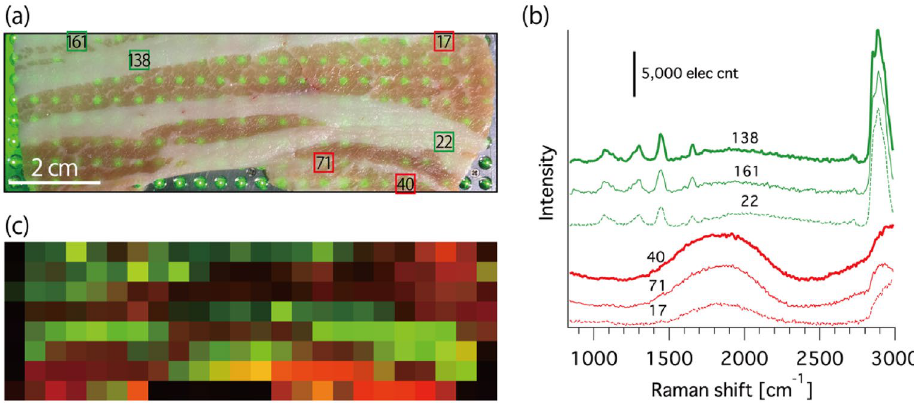
Figure 4. Chemical mapping of a large-scale sample measured by the developed Raman plate reader. ( a ) Photograph of a pork slice under illumination through multiple objective lenses. ( b ) Representative spectra obtained from the sample for the measurement time of 85 s. ( c ) Reconstructed chemical map of the sample. Green: fat (Raman intensity at 2890 cm −1 ), red: Zn-protoporphyrin IX (average intensity of fluorescence peak between 578 and 615 nm; 1496–2530 cm −1